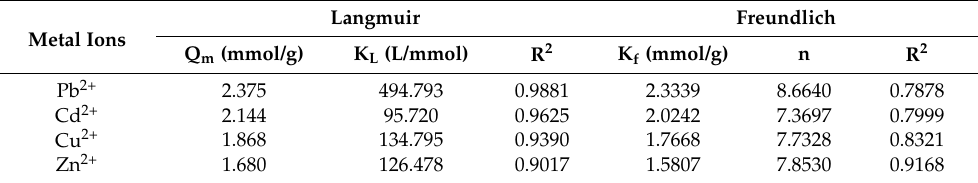
Table 2. Isotherm parameters for Pb 2+ , Cd 2+ , Cu 2+ and Zn 2+ sorption using